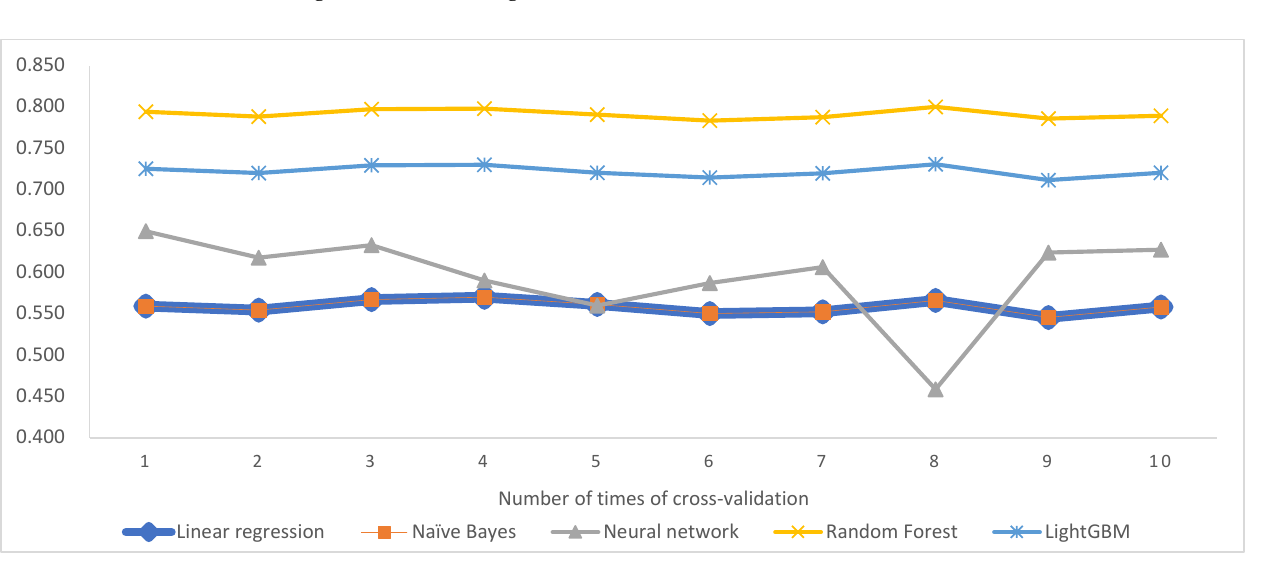
Figure 2. Scores of the models each time. Table 9. Average scores of the 10-fold cross-validation.